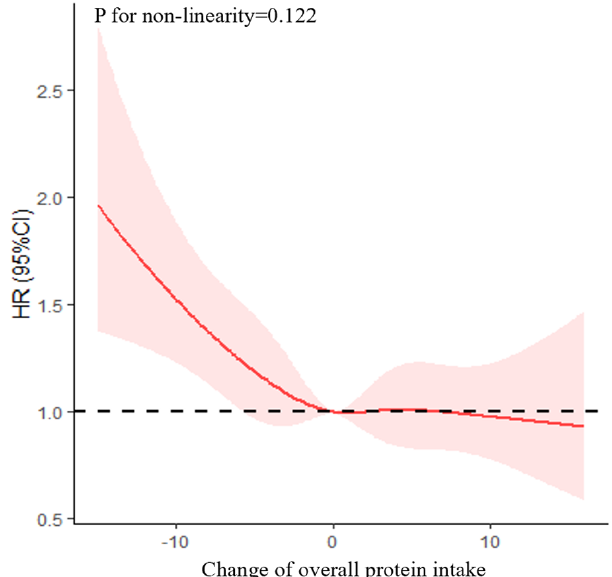
Figure 2. Association between change in overall protein intake and cognitive impairment based on a restricted cubic spline model after adjusting for age (continuous), gender, residence, years of schooling, marital status, economic status, living pattern, tobacco smoking, alcohol drinking, regular exercise, ADL, IADL, BMI, and chronic disease (hypertension, diabetes, heart disease, stroke or CVD, cataract, digestive system disease, arthritis, Parkinson’s disease). The red line represents the HR, the shade of pink represents the 95% CI, and the dotted line represents the reference HR of